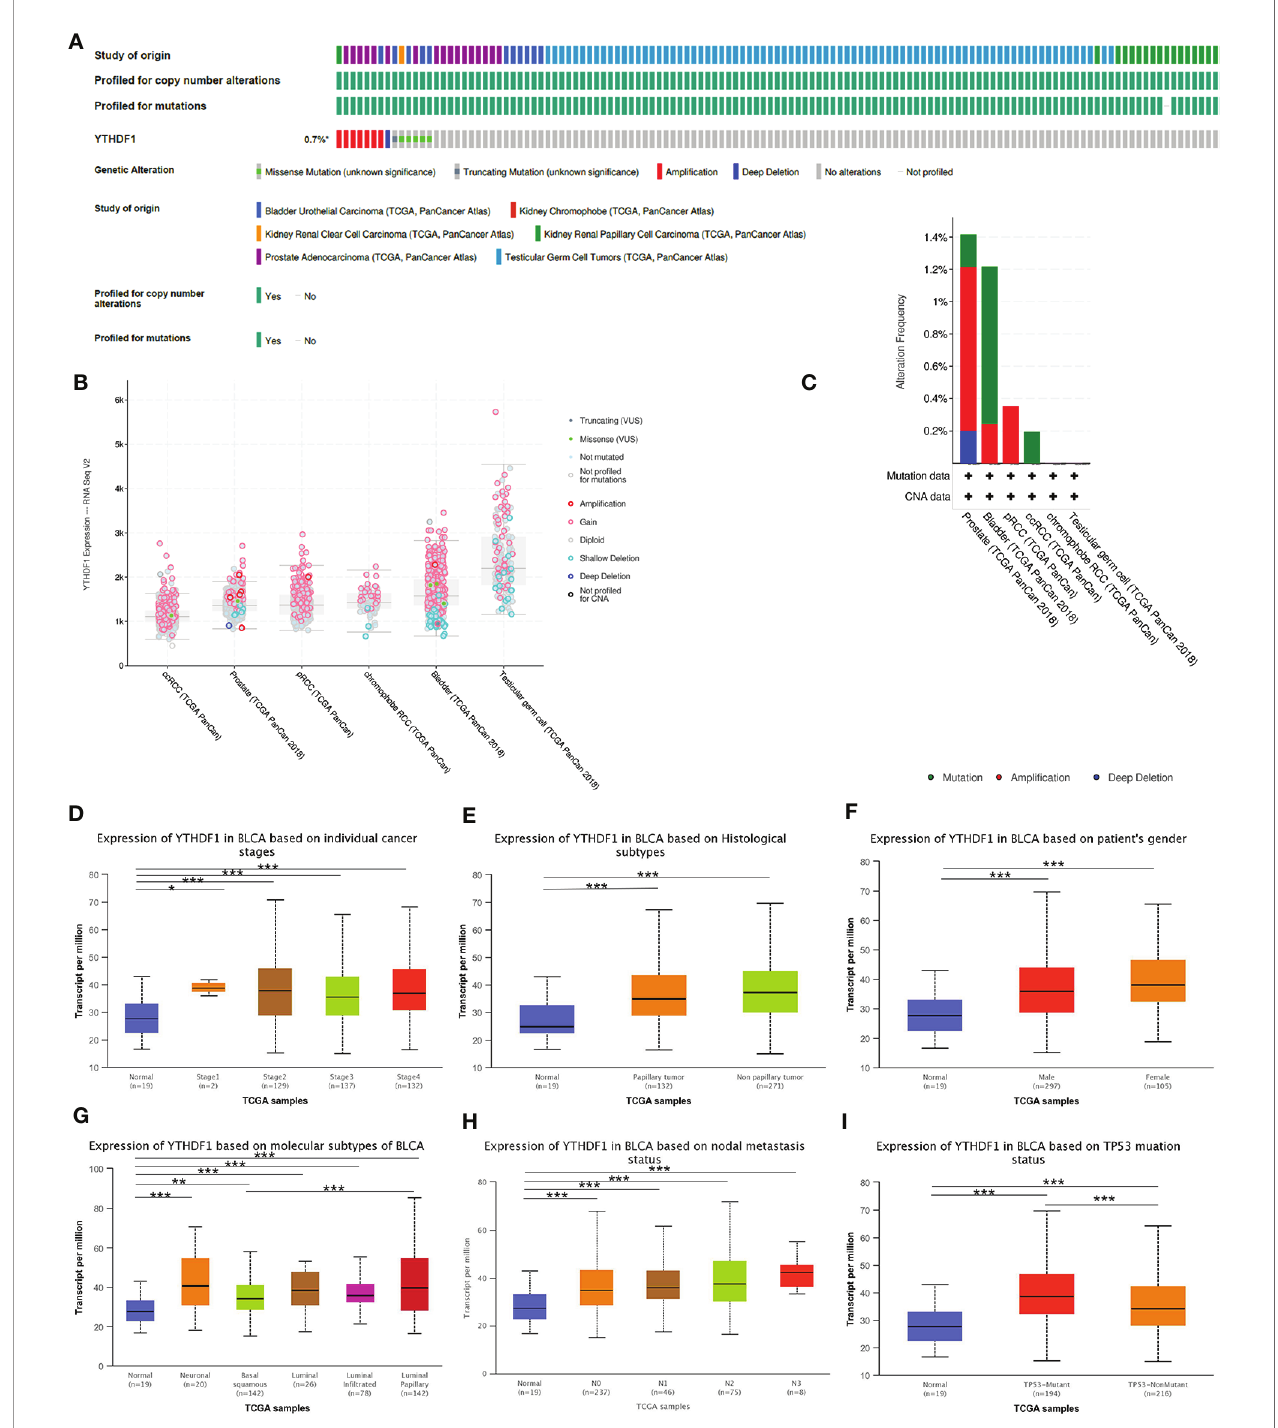
FIGURE 8 | YTHDF1 genomic alterations in six urogenital cancers analyzed by the cBioPortal database (A – C) and YTHDF1 differential expression in bladder cancer with different clinical subgroups (D – I) analyzed by the UALCAN database. (A) OncoPrint of YTHDF1 gene alterations in cancer cohort. (Different colors means different types of genetic alterations and ampli fi cation accounts for the largest proportion). (B) main type of YTHDF1 gene alterations in cancer groups. (C) Details of YTHDF1 gene alteration types in cancer cohort; (D – I) YTHDF1 differential expression in bladder cancer with individual cancer stages (n = 419) (D) , histological subtypes (n = 422) (E) , patient sex (n = 421) (F) , molecular subtypes (n = 427) (G) , nodal metastasis status (n = 385) (H) , TP53 mutation status (n = 429) (I) . (* P < 0.05, ** P < 0.01, *** P <